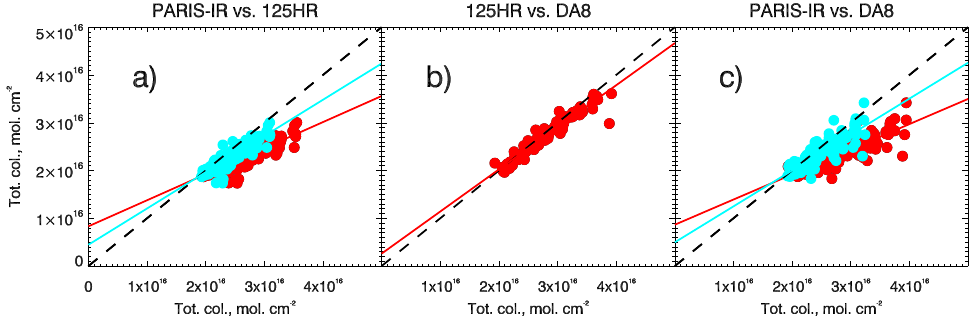
Fig. 3. Total column HNO 3 plots demonstrating the correlation between each combination of the three instruments, before (red) and after (cyan) smoothing of the high-resolution measurements by the PARIS-IR averaging kernel. The 1-to-1 line is shown in black. (a) PARIS-IR (y-axis) vs 125HR (x-axis); (b) 125HR (y-axis) vs DA8 (x-axis); (c) PARIS-IR (y-axis) vs DA8 (x-axis). Note that no smoothing is necessary for the 125HR-DA8 comparison, as they are already at the same resolution. Slopes and correlation coefficients are given in Table 2. Table 2. Comparisons between the three ground-based spectrometers, conducted using both unsmoothed, and smoothed 125HR and DA8 to- tal columns from 2007 and 2008, as described in the text. Note that no smoothing is necessary for the 125HR-DA8 comparisons, as they have the same resolution. Difference = (inst1–inst2)/0.5(inst1+inst2), and Mean = mean of these differences, calculated as a percentage. One standard deviation from the mean is also shown (Std Dev). The instrument names have been abbreviated: 125=125HR, and PIR=PARIS-IR. R 2 and Slope are derived from correlation plots, examples of which are shown in Fig. 3. n indicates the number of matched pairs included in the statistics. Unsmoothed Smoothed Gas